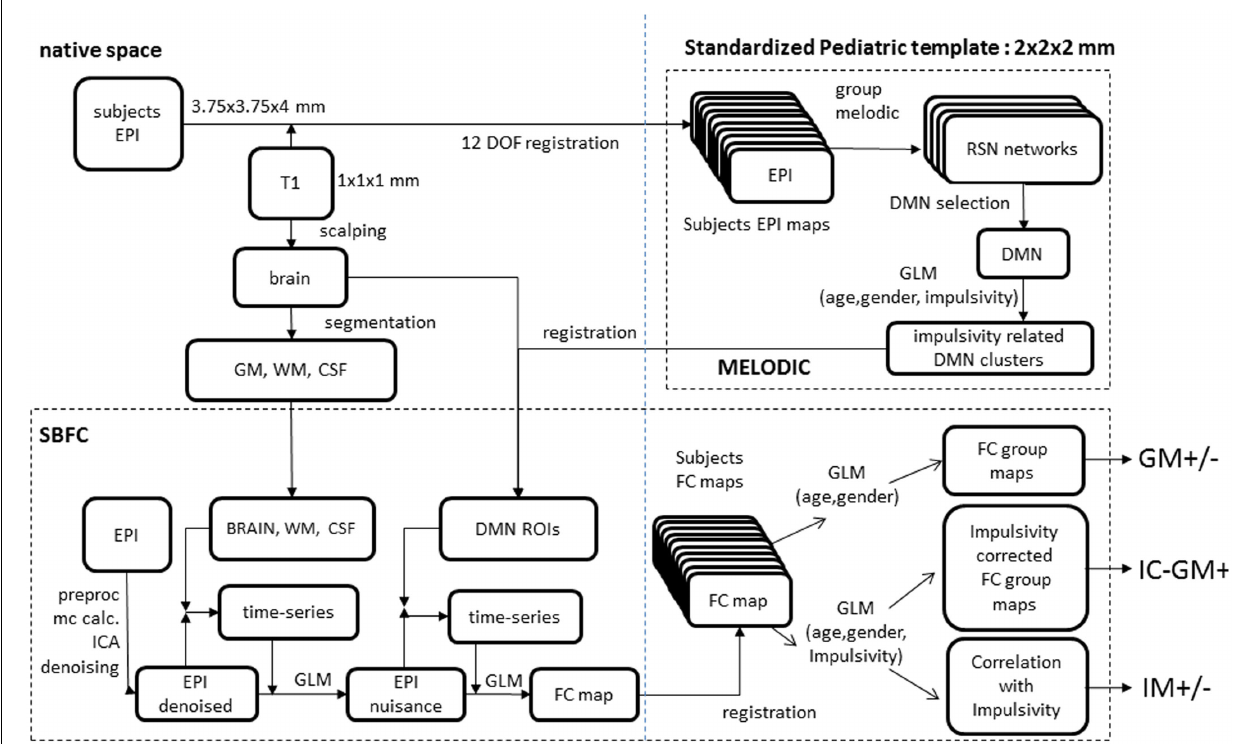
FIGURE 1 | Analyses scheme. (Upper right) melodic analysis. (lower pane) seed-based functional connectivity analysis. Details of EPI to custom template registration, involving anatomical T1 and one-volume whole-brain EPI images were omitted for